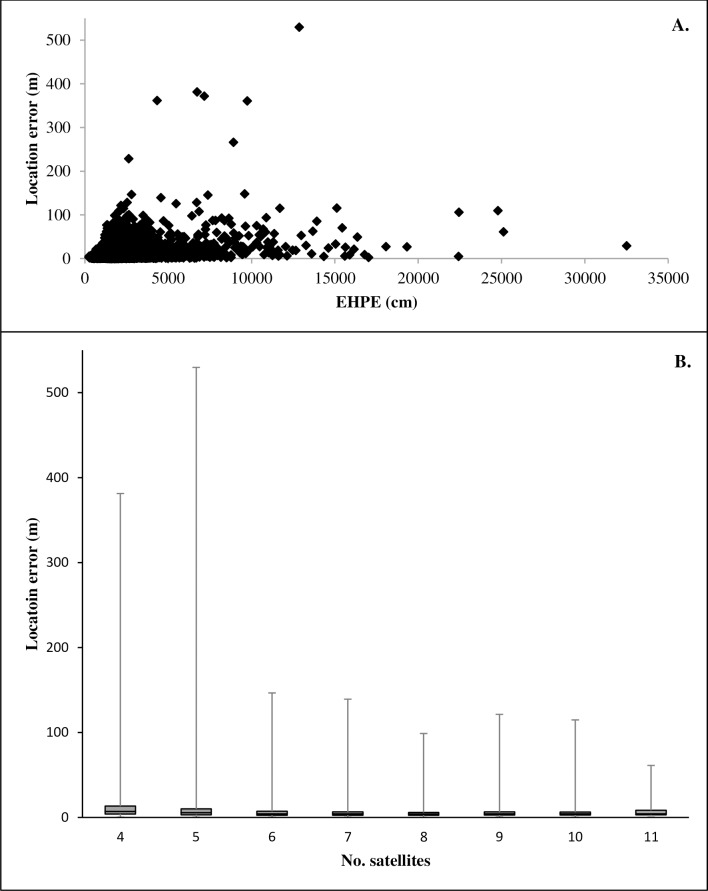
A) Scatterplot showing the relationship between location error and estimated horizontal position error (EHPE) and B) box and whiskers plot showing relationship between number of satellites and EHPE. Data were collected in Baker County, Georgia, USA in March and December 2014 and October 2015.